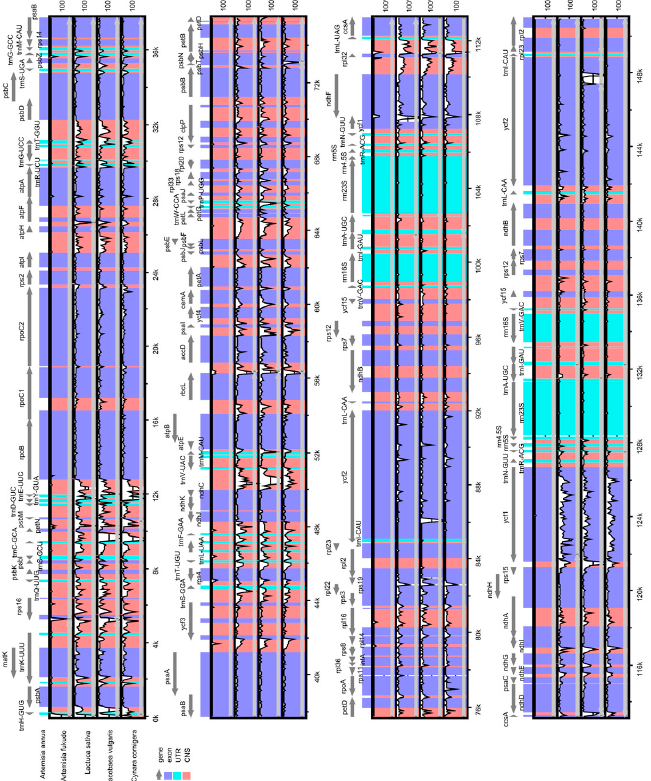
Figure 2. Comparison of five chloroplast genomes using mVISTA. Grey arrows and thick black lines above the alignment indicate gene orientation. Purple bars represent exons, blue bars represent UTRs, and pink bars represent non-coding sequences (CNS). The Y-scale axis represents the percent identity (shown: 50–100%). Genome regions are color-coded as either protein-coding exons, rRNAs, tRNAs, or conserved noncoding sequences (CNS).